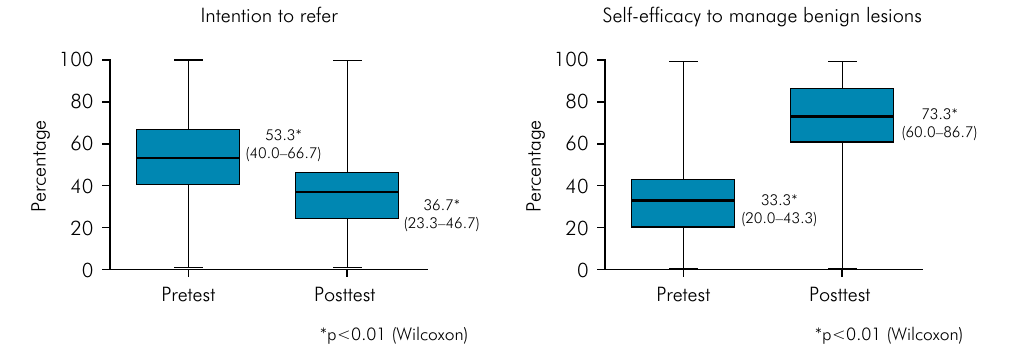
Figure 3. Participants’ self-efficacy in pretest and posttest